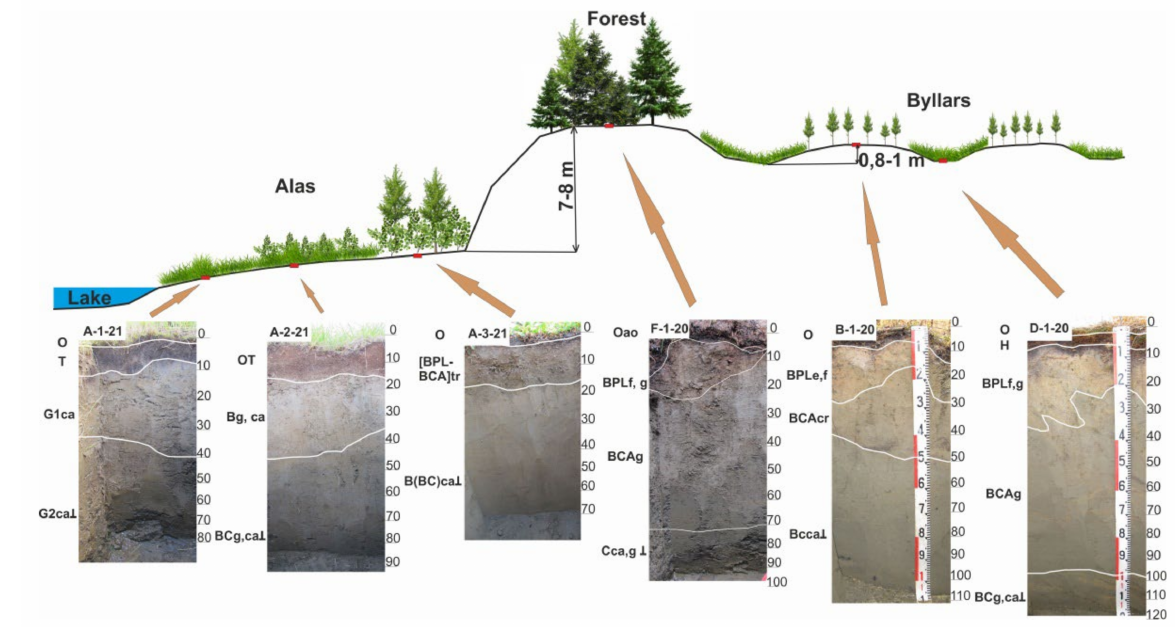
Figure 4. Soil profiles on the studied